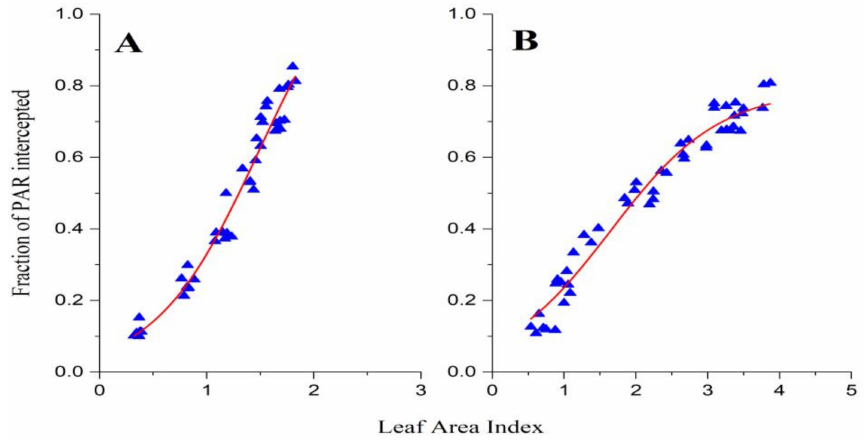
Figure 6. Relationship between LAI and iPAR in 2018 ( A ) and 2019 ( B ).